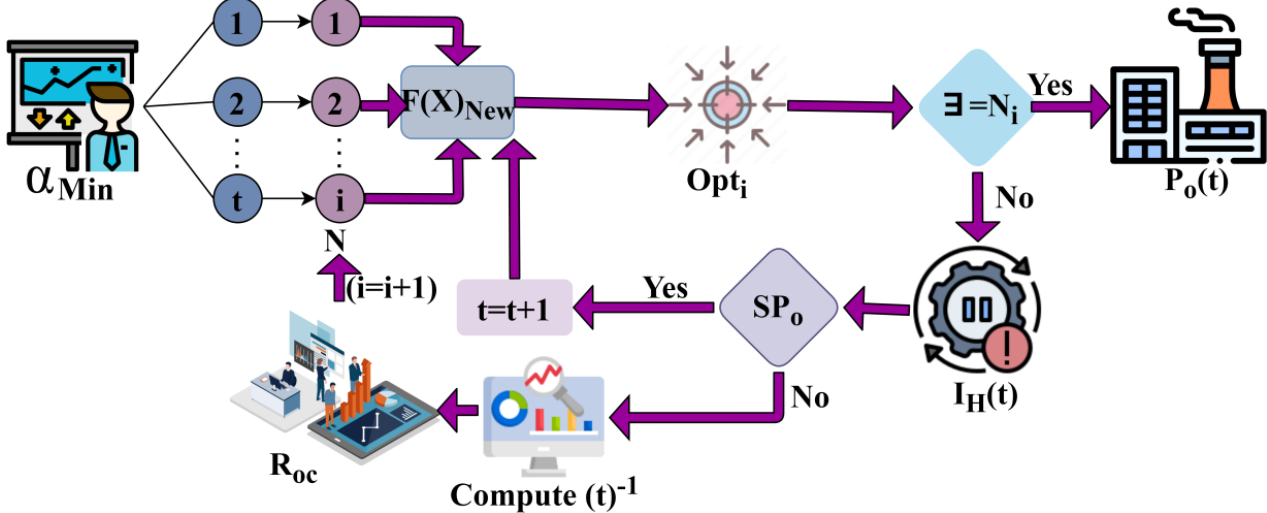
Figure 3. Risk Occurrence Estimation.